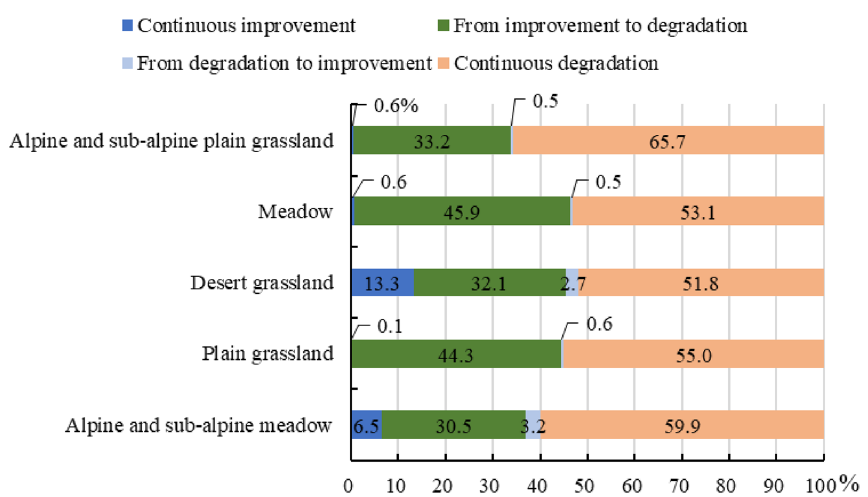
Figure 8. Dynamic changes in grassland